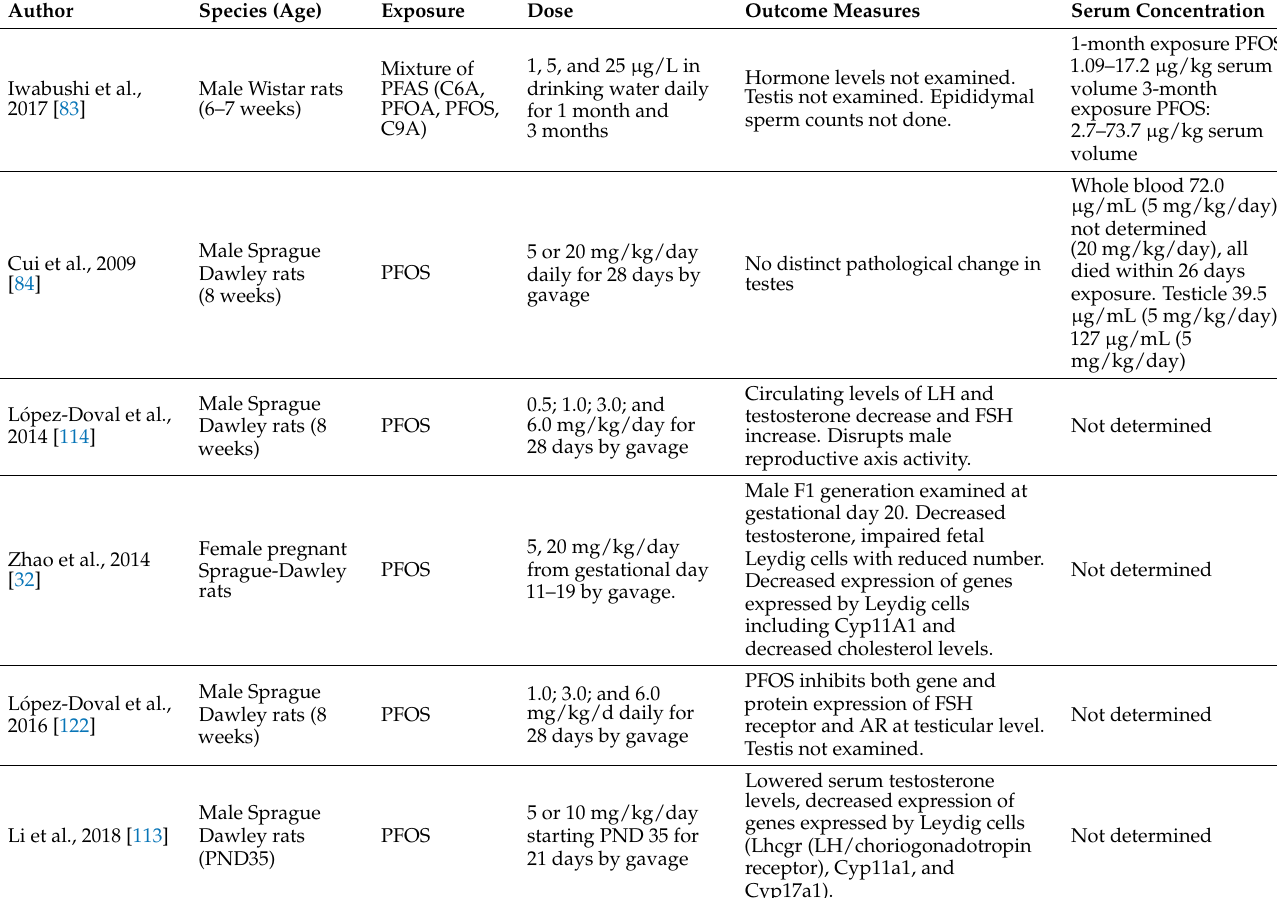
Table 3. PFOS exposure and male fertility measures in